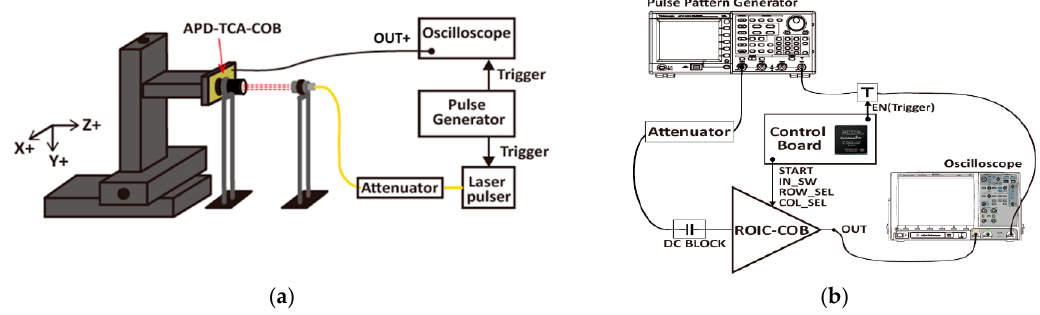
Figure 11. Measurement setup for ( a ) the optical response test and ( b ) the electrical response test.